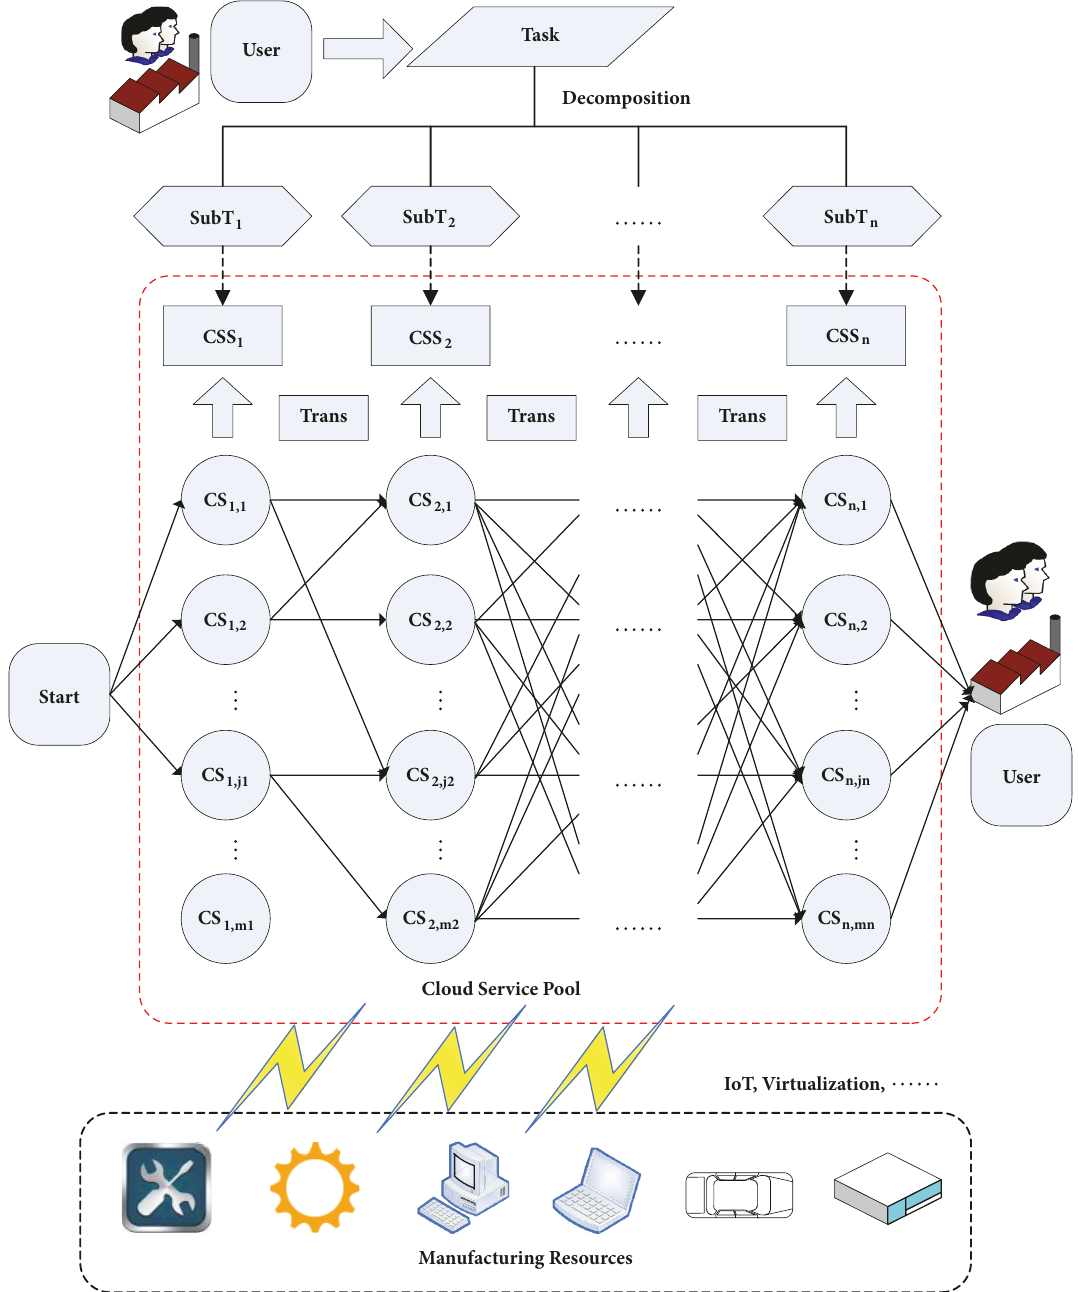
Figure 2: Schematic of cloud service composition for cloud